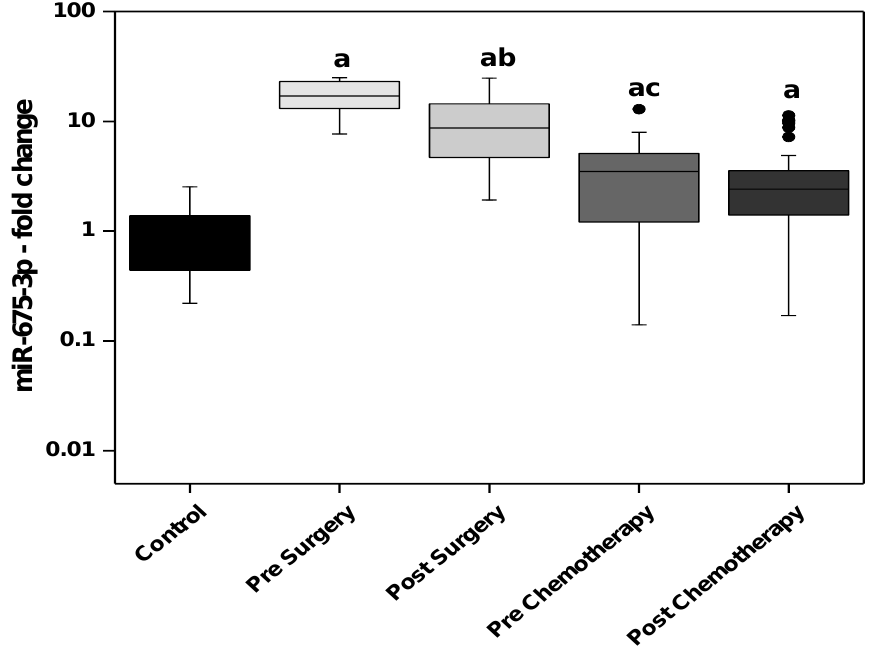
Figure 4. The circulating levels of miR-675-3p in the control subjects and the BC studied groups; surgery only and adjuvant chemotherapy. Extreme value: a — Significant between control and each group by using Post Hoc Test (Dunn’s), Kruskal Wallis test , b — Significant between pre and post in same group by using Wilcoxon signed ranks test, c — Significant between post-surgery and prechemotherapy by using Mann Whitney test